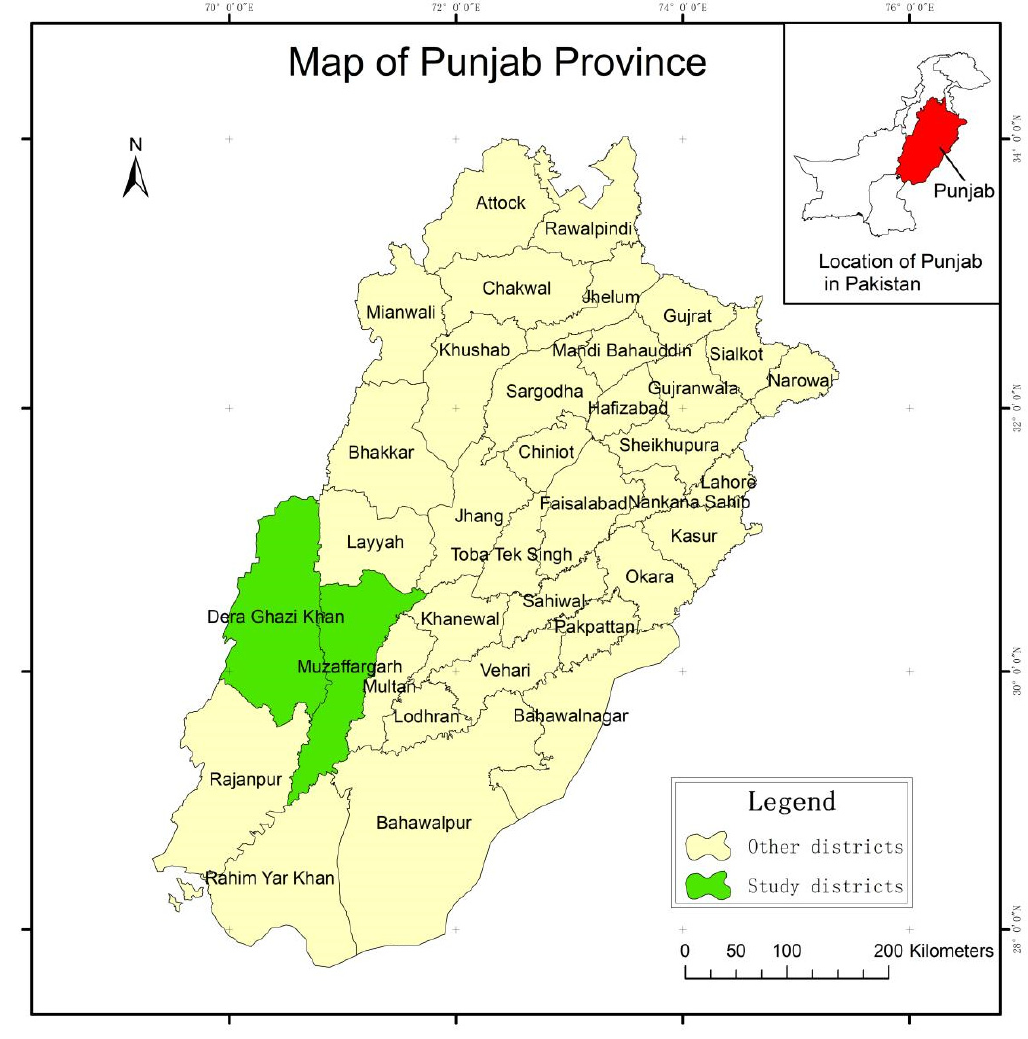
Figure 3. Study-area map .